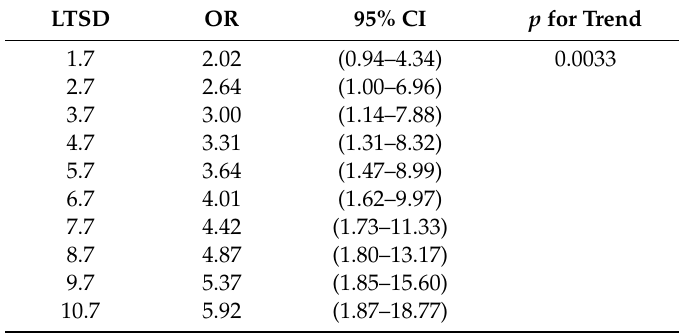
Table 6. OR and 95% CI for the restrictive cubic spline of